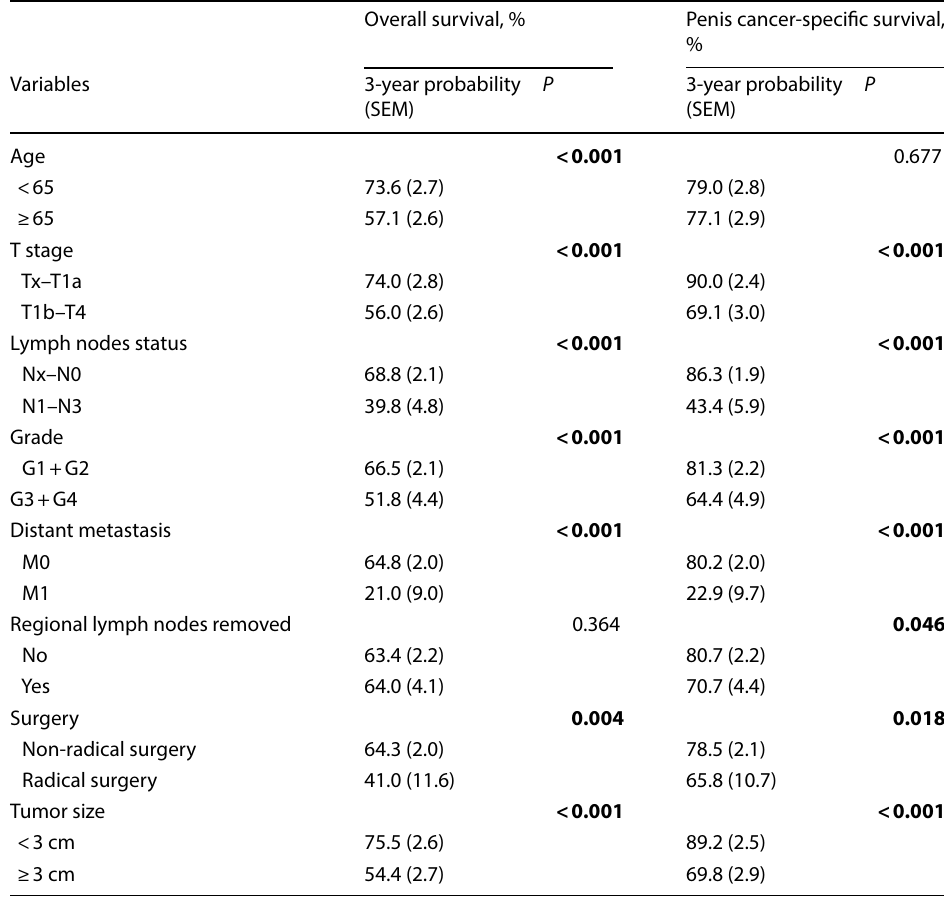
Table 2 Kaplan–Meier analyses predicting overall survival and penis cancer- specific survival in 1001 patients with